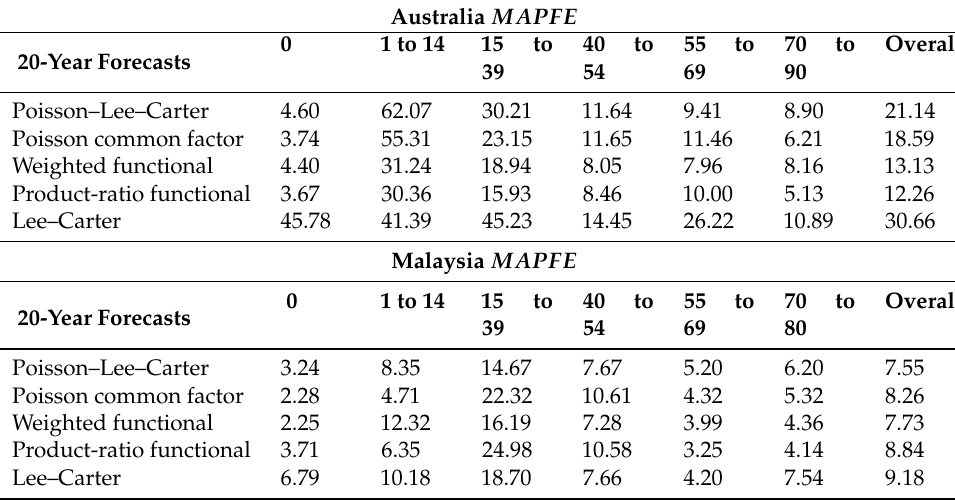
Table 3. Mean Absolute Percentage Forecast Error ( MAPFE ) of the male-to-female death rate ratios by age, method and